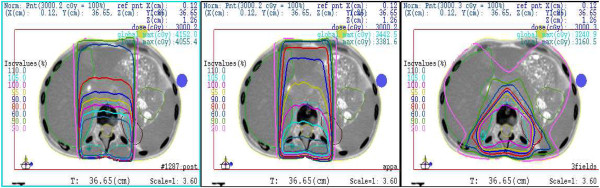
PA, AP-PA and 3D conformal plans for a typical patient. Three representative plans are displayed in axial view for 3D conformal, AP-PA and PA beams technique.